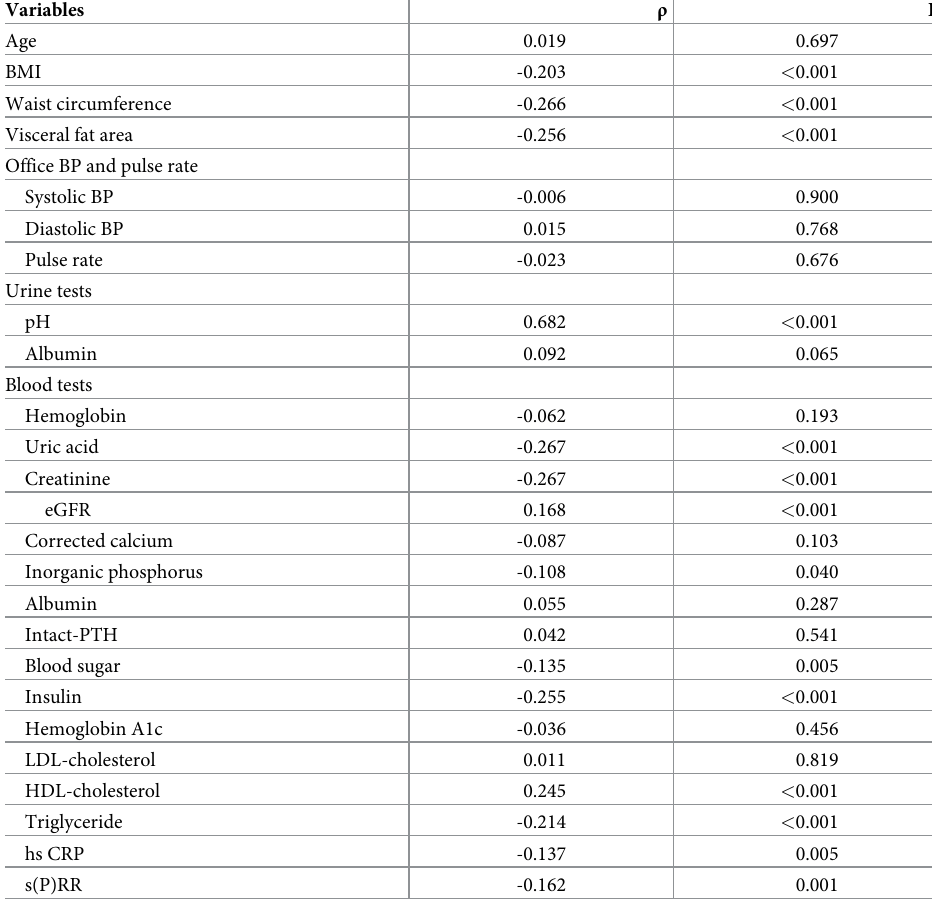
Table 2. Single correlation analyses with urinary soluble (pro)renin receptor excretion